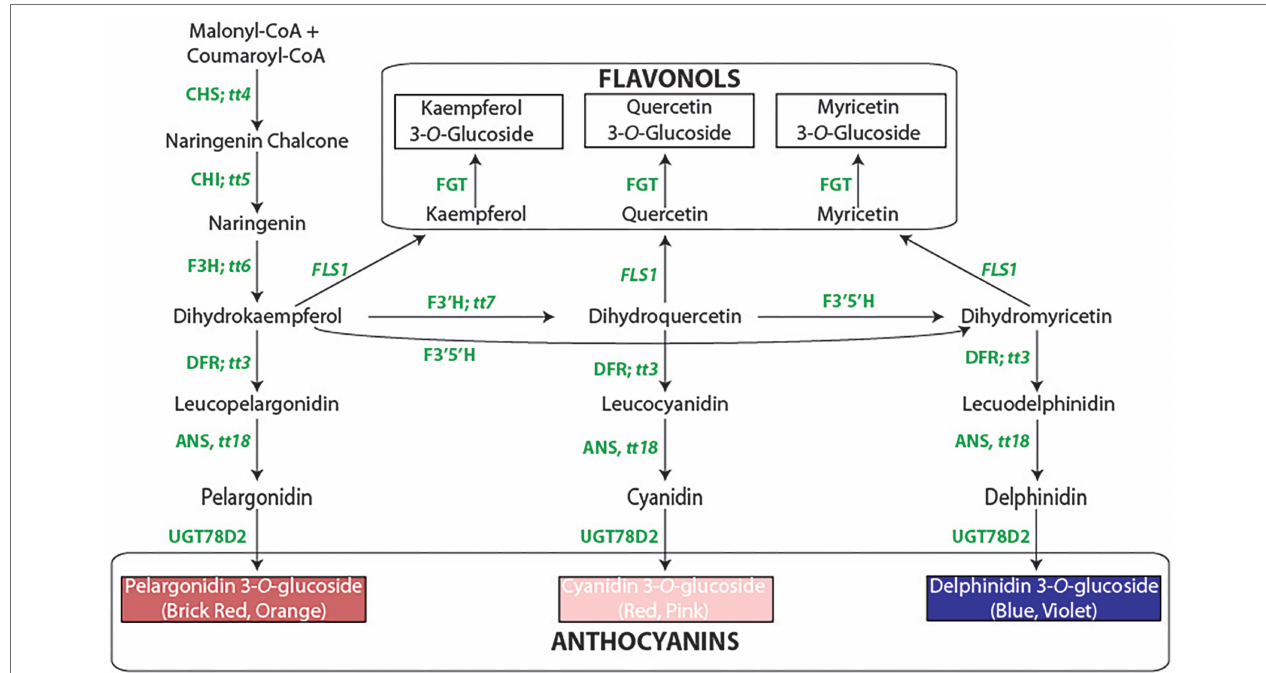
FIGURE 1 | The flavonoid biosynthetic pathway. The enzyme abbreviations [followed by the Arabidopsis gene symbols, beginning with tt = transparent testa]: CHS, chalcone synthase; CHI, chalcone isomerase; F3H, flavanone 3-hydroxylase; F3 ′ H, flavonoid 3 ′ -hydroxylase; F3 ′ 5 ′ H, flavonoid 3 ′ 5 ′ -hydroxylase; DFR, dihydroflavonol 4-reductase; ANS, anthocyanidin synthase; UGT78D2, flavonol-3- O -glucosyltansferase; FLS, flavonol synthase. The methylated derivatives of cyanidin (peonidin) and delphinidin (petunidin and malvidin) are not